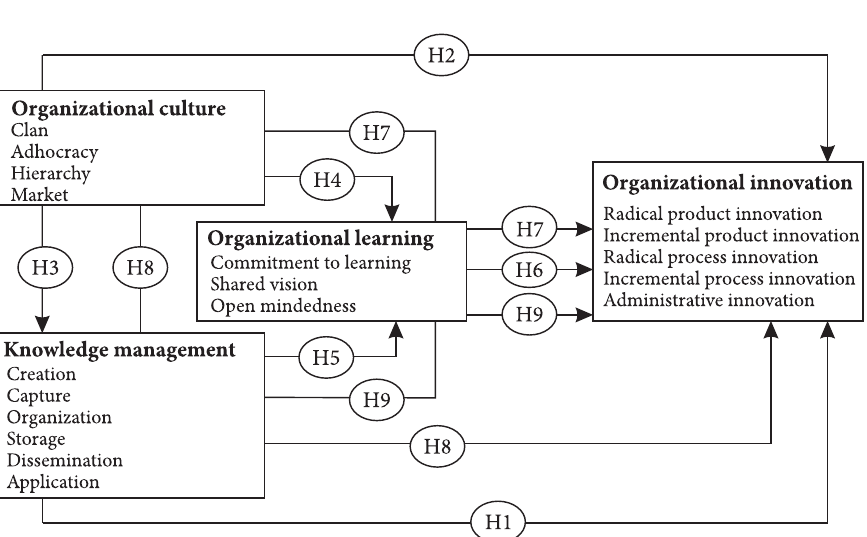
Figure 1. Theoretical framework of the